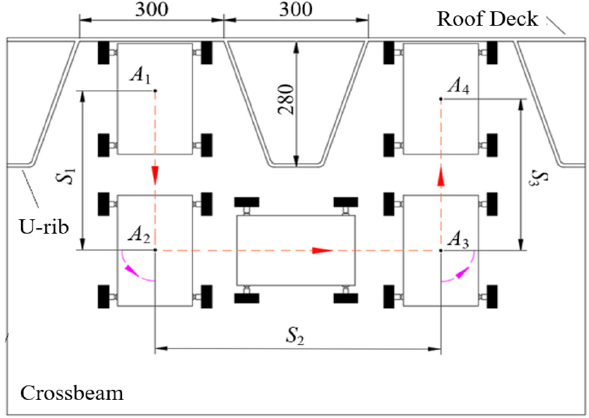
Figure 9. Desired tracking path of the robot steering to adjacent lane.